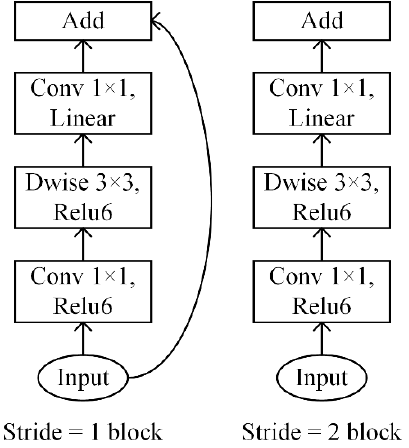
Figure 2. Structure of the building block of MobileNetV2.